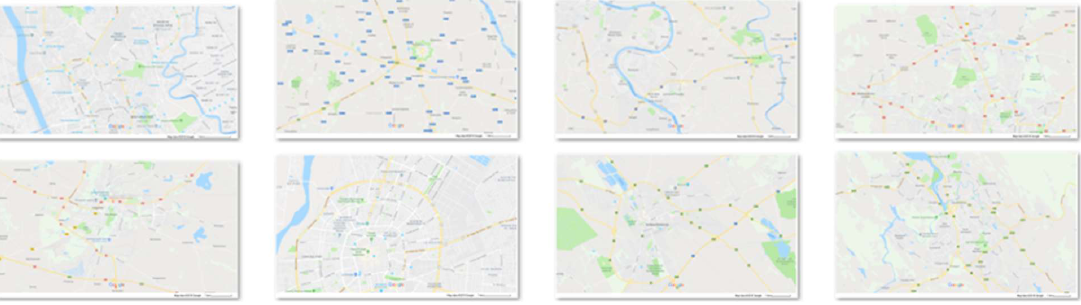
Figure A7. Examples of map stimuli in CartoGAZE dataset. 4.